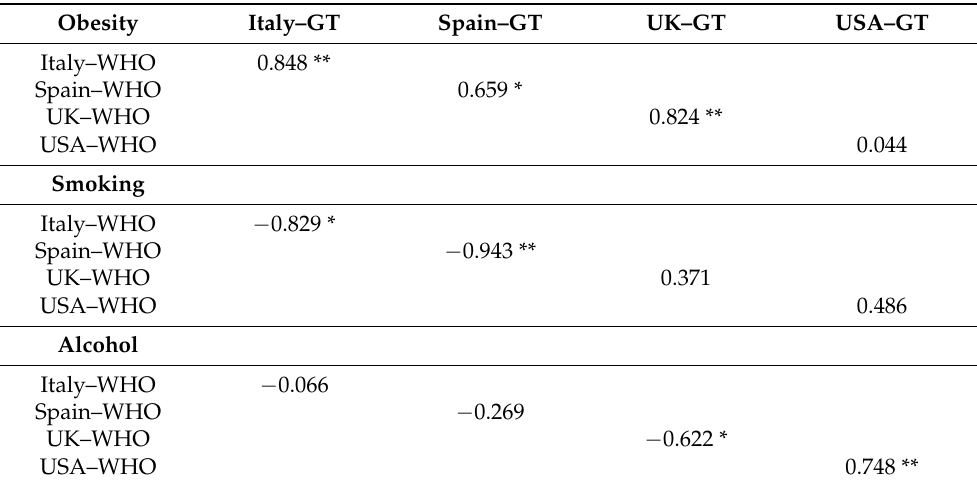
Table 3. Correlations between official data (The Global Health Observatory–World Health Organiza- tion) and Google